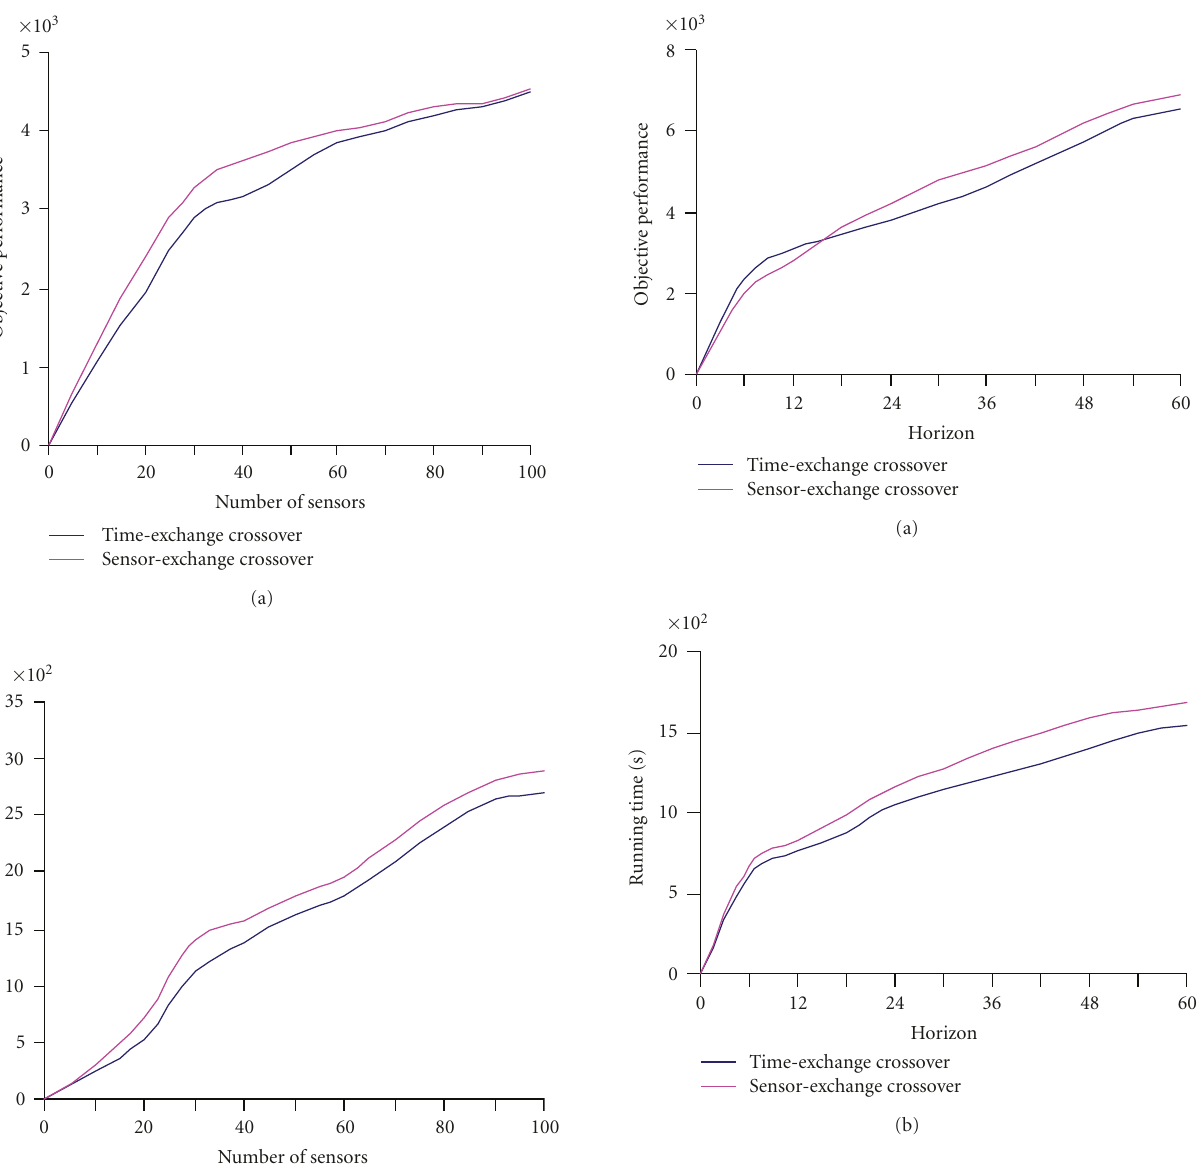
Figure 10: A comparison between time-exchange and sensor- exchange crossover operators performance with increasing the hori- zon: (a) objective performance and (b) running